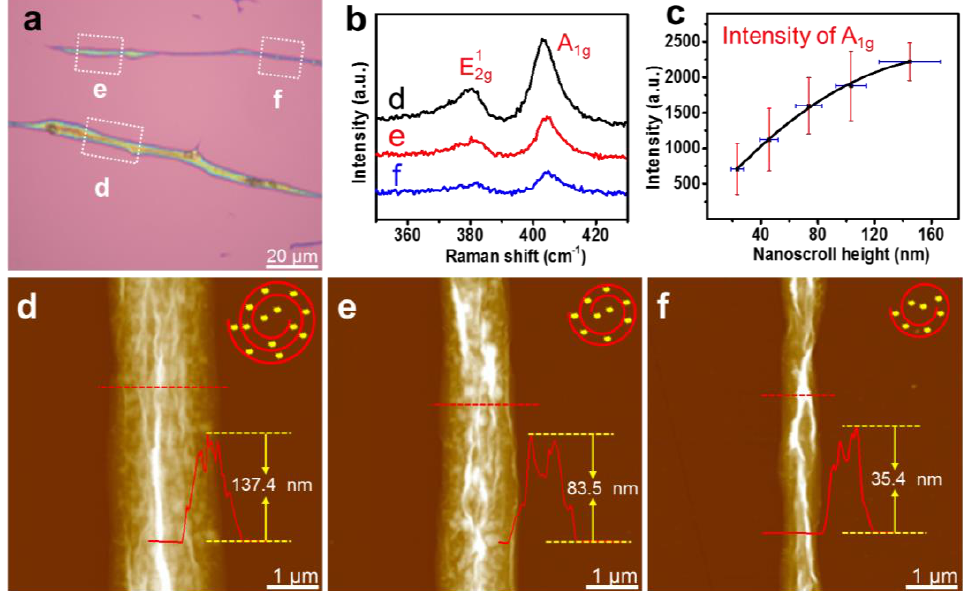
Figure 2. ( a ) The OM image of the MoS 2 @RGO nanoscrolls. ( b ) The Raman spectra of MoS 2 @RGO marked by dashed boxes of d, e and f shown in ( a ). ( c ) The plot of the Raman intensity of A 1g peak as a function of the height of the MoS 2 @RGO nanoscrolls. ( d – f ) The corresponding AFM images of the MoS 2 @RGO nanoscroll marked by dashed boxes of d, e and f shown in ( a ).